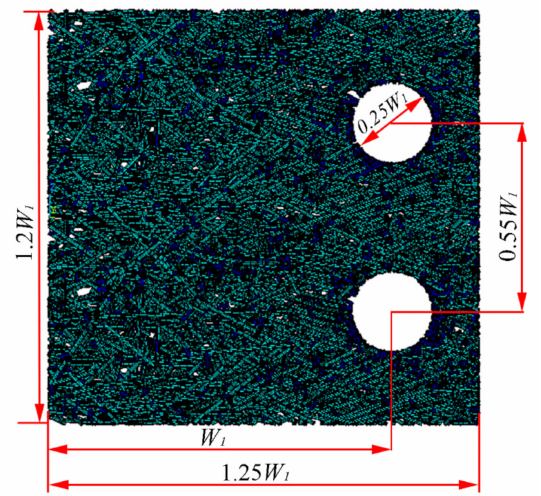
Figure 6. The FE model of the CT specimen (the width W 1 is 1.4 L , L is the average fiber length (0.6 mm), the thickness of the FE model B 1 is W 1 / 2).